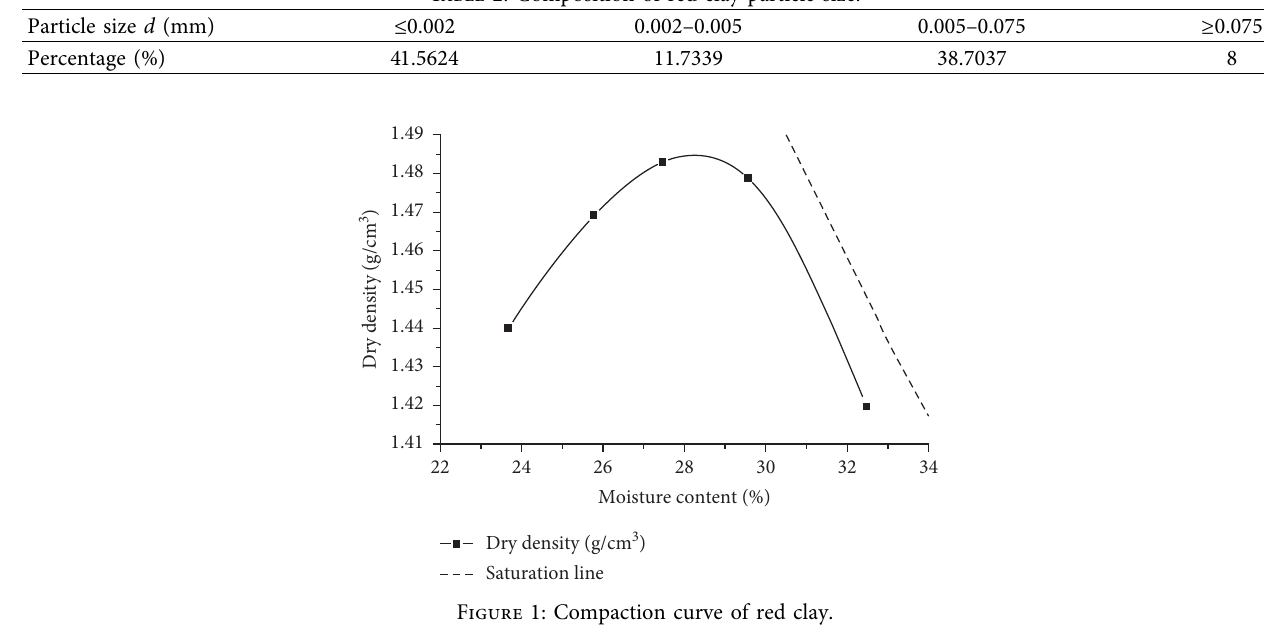
Table 2: Composition of red clay particle size.